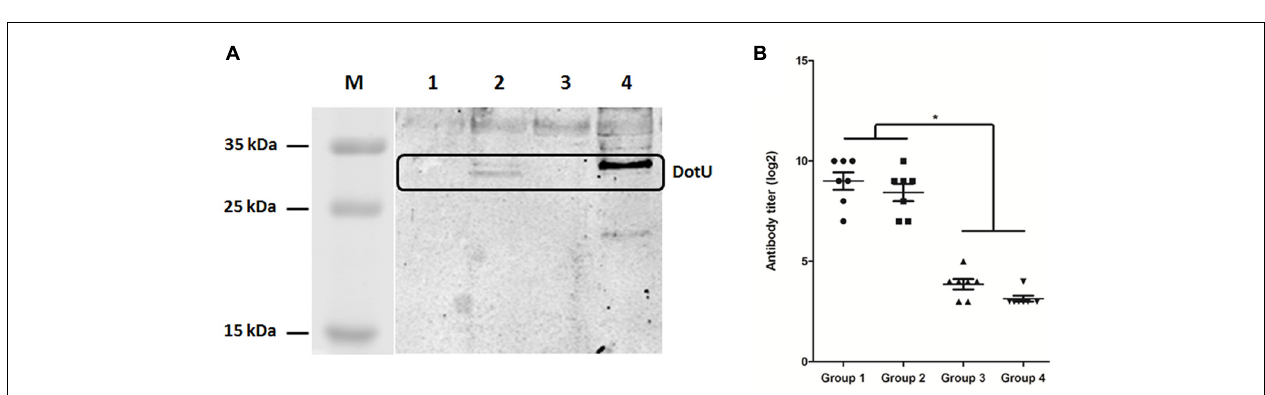
expression.Transcript levels of hcp1 , hcp2 , vgrG , dotU , evfJ, and evfL in DE719 and DE719 (cid:2) dotU analyzed by qRT-PCR. Data were normalized to the housekeeping gene dnaE and shown as fold changes.